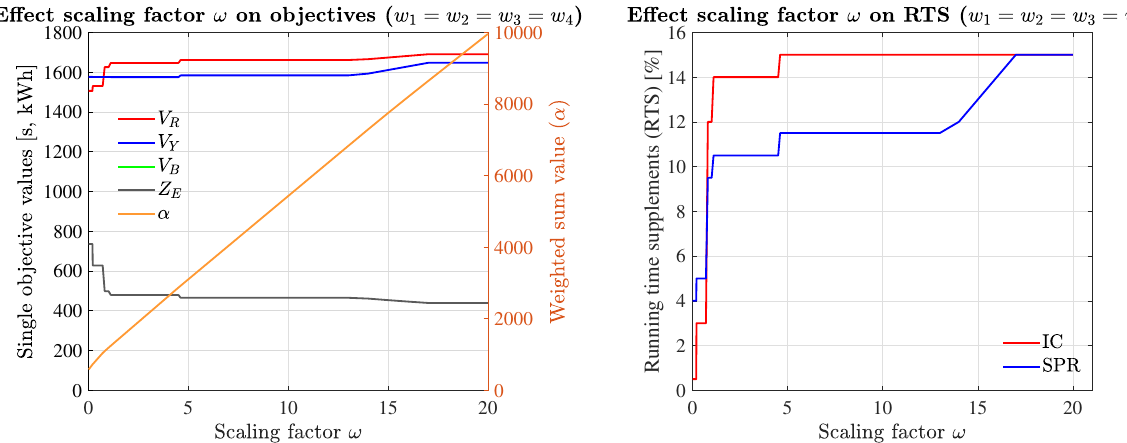
Figure 13: The left plot shows the sensitivity analysis by varying the scaling factor of the energy consumption 𝜔 related to the single objectives (left y-axis) and weighted sum value (right y-axis). The right plot indicates the running time supplements (RTS) for the IC and SPR given the vary- ing weight factor of the energy consumption 𝜔